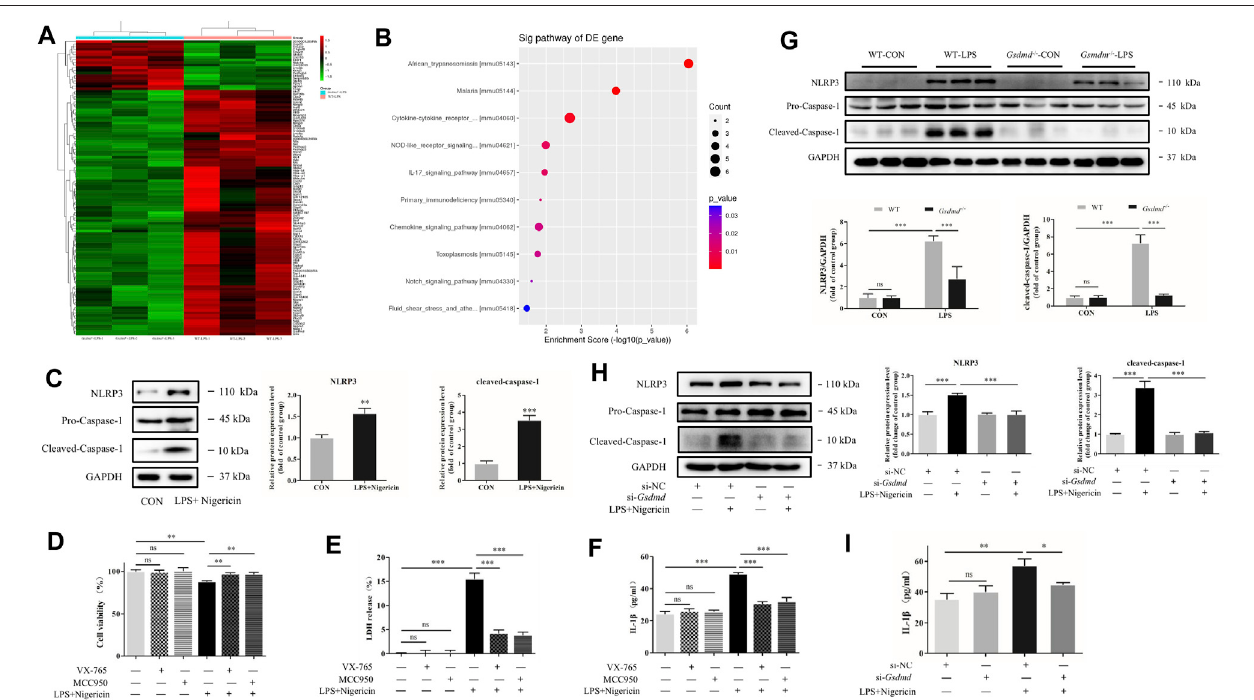
FIGURE 5 | GSDMD regulated NLRP3 in fl ammasome activation in septic myocardial dysfunction induced by LPS. (A,B) Heat map and Kyoto Encyclopedia of Genes and Genomes (KEGG) pathway analyses of the transcriptome of heart tissues from WT and Gsdmd − / − (n (cid:1) 3) mice treated with LPS. (C) Expressions of NLRP3 and caspase-1 protein in H9c2 cells were measured by Western blotting analysis. The results were normalized to the expression of GAPDH. (D) H9c2 cells were pretreated with NLRP3 inhibitor or caspase-1 inhibitor for 1 h and subsequently stimulated with LPS plus nigericin. CCK-8 assay was applied to measure cell viability of each group (n (cid:1) 4). (E) The LDH release in supernatants of each group (n (cid:1) 3). (F) The level of IL-1 β in supernatants of each group (n (cid:1) 3). (G) Expressions of NLRP3 and caspase-1 protein in heart tissue were measured by Western blotting analysis. The results were normalized to the expression of GAPDH (n (cid:1) 6). (H) After transfected with siRNA of Gsdmd , H9c2 cells were treated with LPS and nigericin to establish the myocardial injury model. Expressions of NLRP3, caspase-1, and P65 proteininH9c2cellsweremeasuredbyWesternblottinganalysis.TheresultswerenormalizedtotheexpressionofGAPDH(n (cid:1) 3). (I) ThelevelofIL-1 β insupernatantsof each group (n (cid:1) 3). The data are expressed as the mean ± SD. * p < 0.05, ** p < 0.01, *** p <